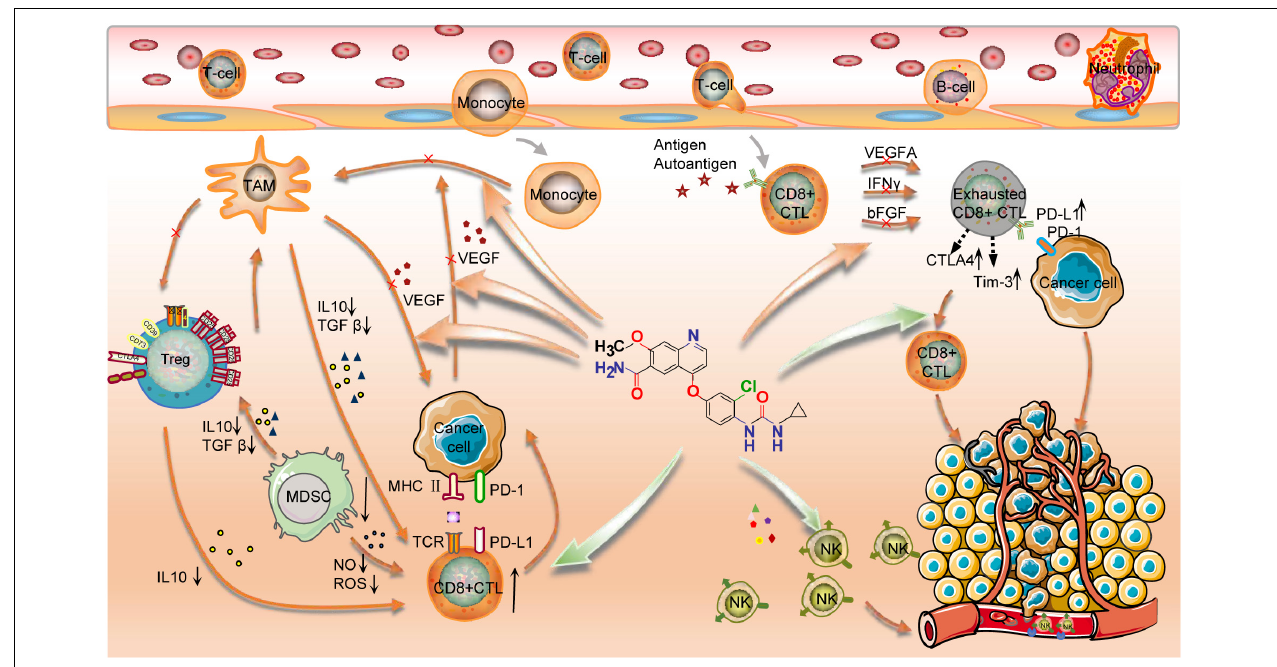
FIGURE 6 | Mechanisms of action of lenvatinib in combination with ICB. Lenvatinib promoted the number and function of CD8 + T cells and inhibited the number and function of Tregs and Macrophages M2; Lenvatinib enhanced the cytotoxicity of NK cells; Lenvatinib decreased the expression of PD-1, CTLA-4, and TIM3 in T cells and inhibited the exhaustion of T cells; Lenvatinib also inhibits tumor angiogenesis and abnormalities by inhibiting the secretion of angiogenic factors, such as VEGF, FGF, and PDGF, etc. Finally, PD-1/PD-L1 Ab restores the exhausted T cell activity to kill the cancer cell. Therefore, this combination has a synergistic anti-tumor